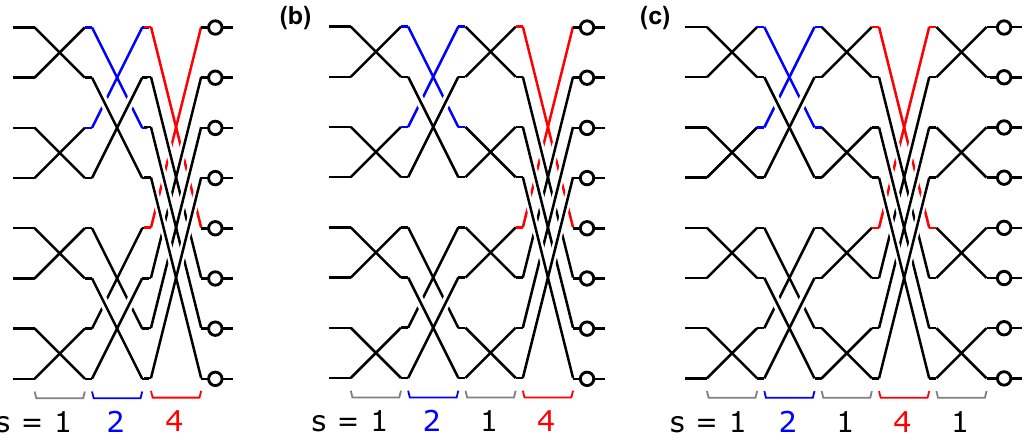
Figure 5: The SCF mesh at different stages of pruning constructed by interleaving strides from the largest successively to the smallest, from left to right with the number of columns limited by